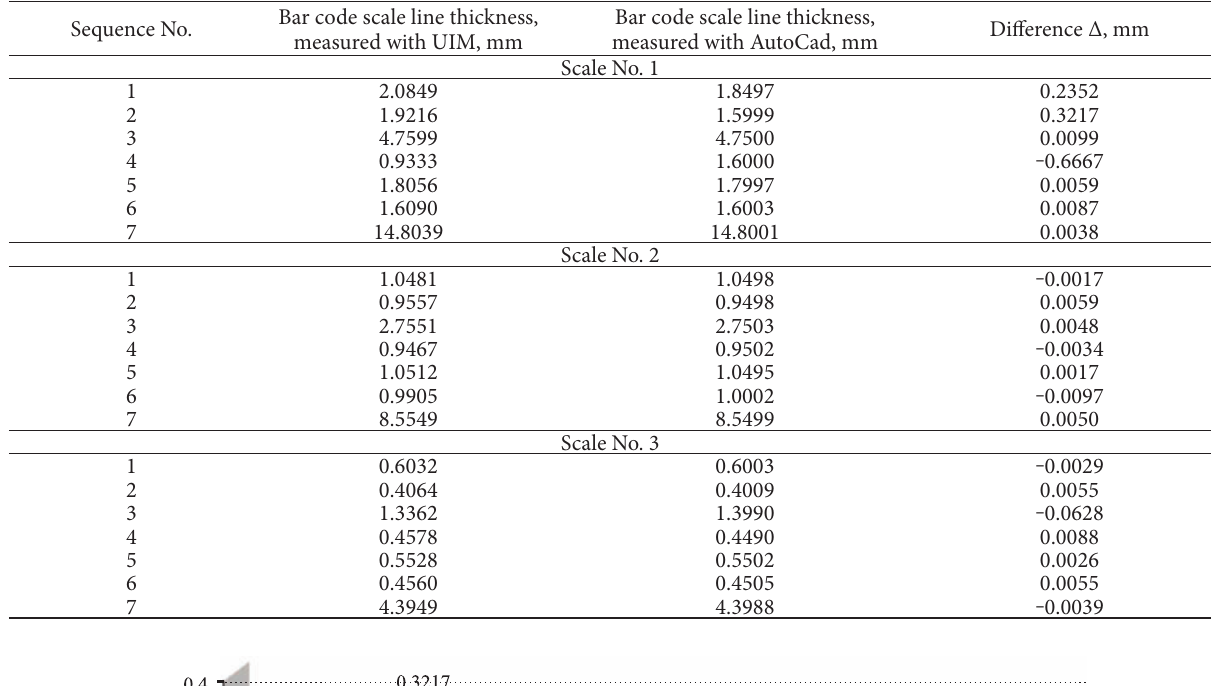
Table 2. The line thickness of the bar code scale measured with a microscope and the AutoCAD environment Bar code scale line thickness, Bar code scale line thickness, Sequence No. measured with UIM, mm measured with AutoCad,